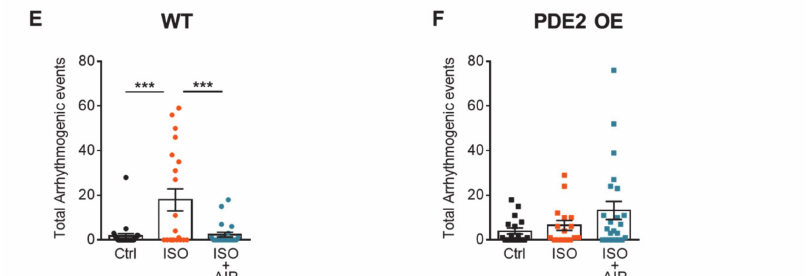
Figure 4. Ca 2+ /calmodulin-dependent kinase II (CaMKII)-mediated increase in I NaL and cellular arrhythmogenic events upon β -AR stimulation is abolished in PDE2 OE. Late sodium current (I NaL ) was measured in isolated ventricular cardiomyocytes from PDE2 OE (squares) and WT (circles) mice at − 35 mV (1 s) under basal conditions (black symbols) and after 10 min stimulation with ISO (100 nM, orange), ISO (100 nM) and AIP (1 µ M, blue), ISO (100 nM) and PKI (5 µ M, green), 8-CPT (10 µ M, red), 8-CPT (10 µ M) and AIP (1 µ M, dark blue). ( A , B ) Representative current traces and ( C , D ) quantification of I NaL estimated by integrating I Na between 100 and 500 ms and normalized to the membrane capacitance. *** p < 0.001 vs. control (Ctrl), (N = animals/genotype, 6 ≤ n ≤ 17 cells per group). ( E , F ) Isolated ventricular cardiomyocytes were subjected to an arrhythmia provocation protocol under basal conditions (black), after 10 min stimulation with ISO (100 nM, orange) or ISO (100 nM) and AIP (1 µ M, blue). Arrhythmogenic events (DADs, EADs, and sAPs) were quantified.